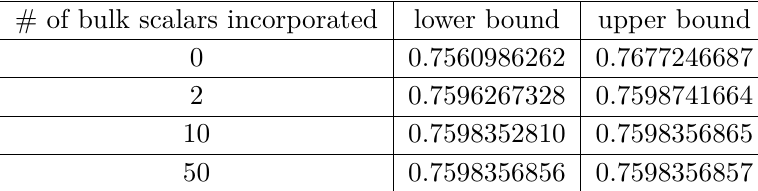
Table 6. Upper and lower bounds on the g function for stable boundary conditions in the SU(3) 1 WZW model at N = 127 derivative order with an increasing number of low-lying bulk scalars incorporated. The bounds appear to be convergent upon 3 − 1 4 = 0 . 75983568565 . .